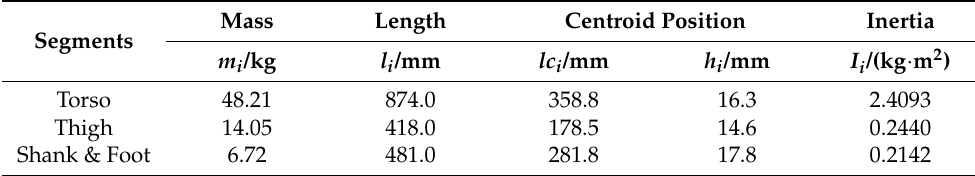
Table 3. The parameters of each body